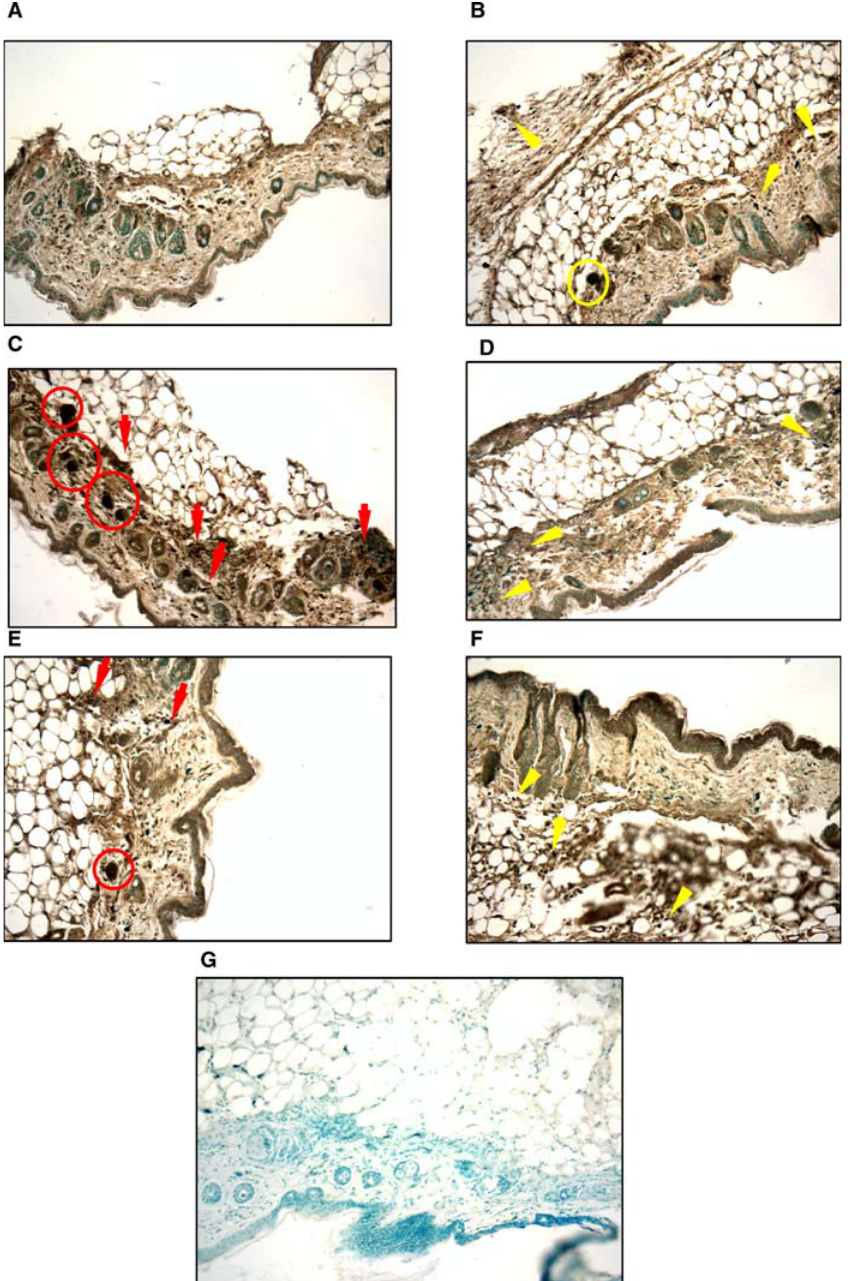
Figure 3. Skin Immunocytochemical Profile of Immunized Mice Infested with Virus-Infected and -Uninfected Ticks Immunocytochemical profiles of skin sections taken at d 4 of TBEV-infected I. ricinus tick challenge on Balb/c mice immunized with either GST (A, B) or TRP5 (C, D), or unimmunized (E, F), using rat anti-mouse CD4 þ antiserum (B, D, and F) and rat anti-mouse CD8 þ (A, C, and E) antiserum, with a negative control sample (G, PBS plus normal rabbit serum). (C) TRP5-immunized mice: red arrowheads ¼ numerous CD8 þ T cells; red circles ¼ CD8 þ T cells occluding the dermal blood vessels; and (D) yellow arrows ¼ CD4 þ T cells. (E) and (F) unimmunized mice, few CD8 þ T cells ¼ red arrows and CD4 þ T cells ¼ yellow arrows/yellow circle, respectively. (B) Control GST-immunized mice yellow arrows ¼ few CD4 þ T cells. (G) PBS-negative control skin sample ¼ no T cells. Magnification 20 3 . DOI: